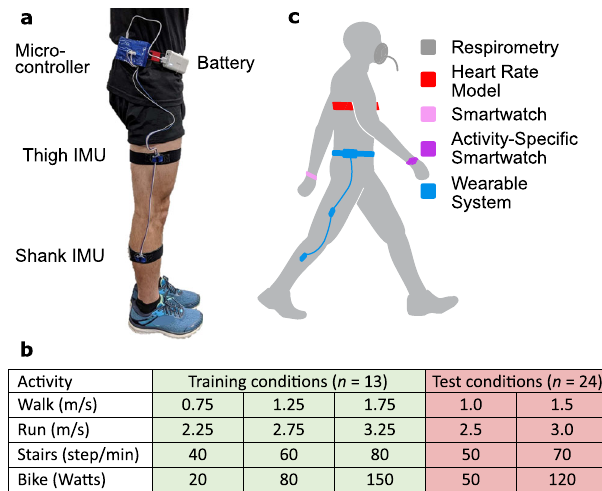
Fig. 1 The Wearable System components, energy expenditure estimation methods, and experimental conditions. a The Wearable System consists of a microcontroller, battery, and an inertial measurement unit (IMU) attached to the shank and thigh on one leg. b The Wearable System estimated energy expenditure in real-time, using a model trained with data from 13 subjects completing three conditions of walking, running, stair climbing, and biking. The trained model was held constant to test the Wearable System with 24 new subjects during two different steady-state conditions for the same activities and four new time-varying conditions. These subjects had not participated in previous experiments and were selected to emulate a diverse adult population. c The Wearable System was compared with commercial devices including the Smartwatch and the Activity-Speci fi c Smartwatch as well as baselines including the Heart Rate Model, Per-Breath Respirometry, and Fast-Estimated